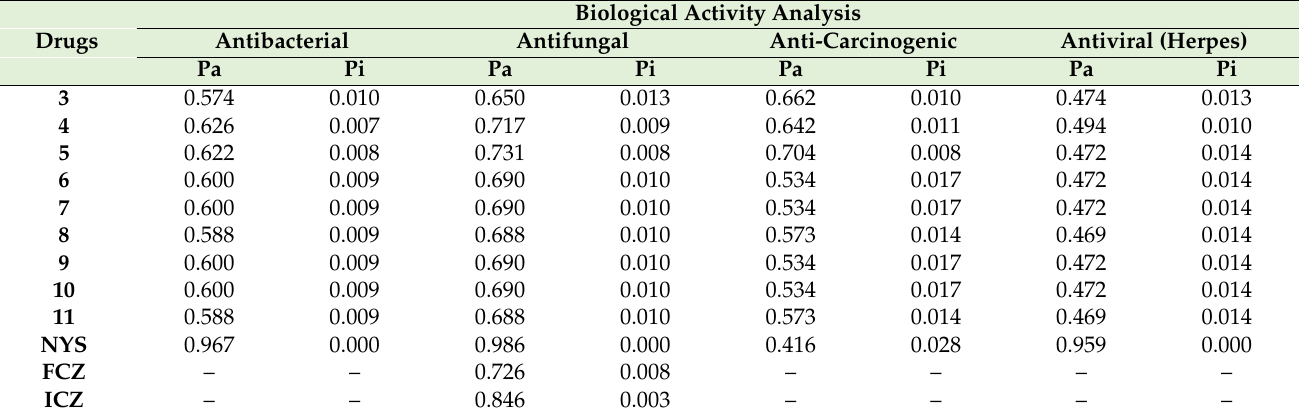
Table 2. PASS analyzed biological properties of rhamnose esters.